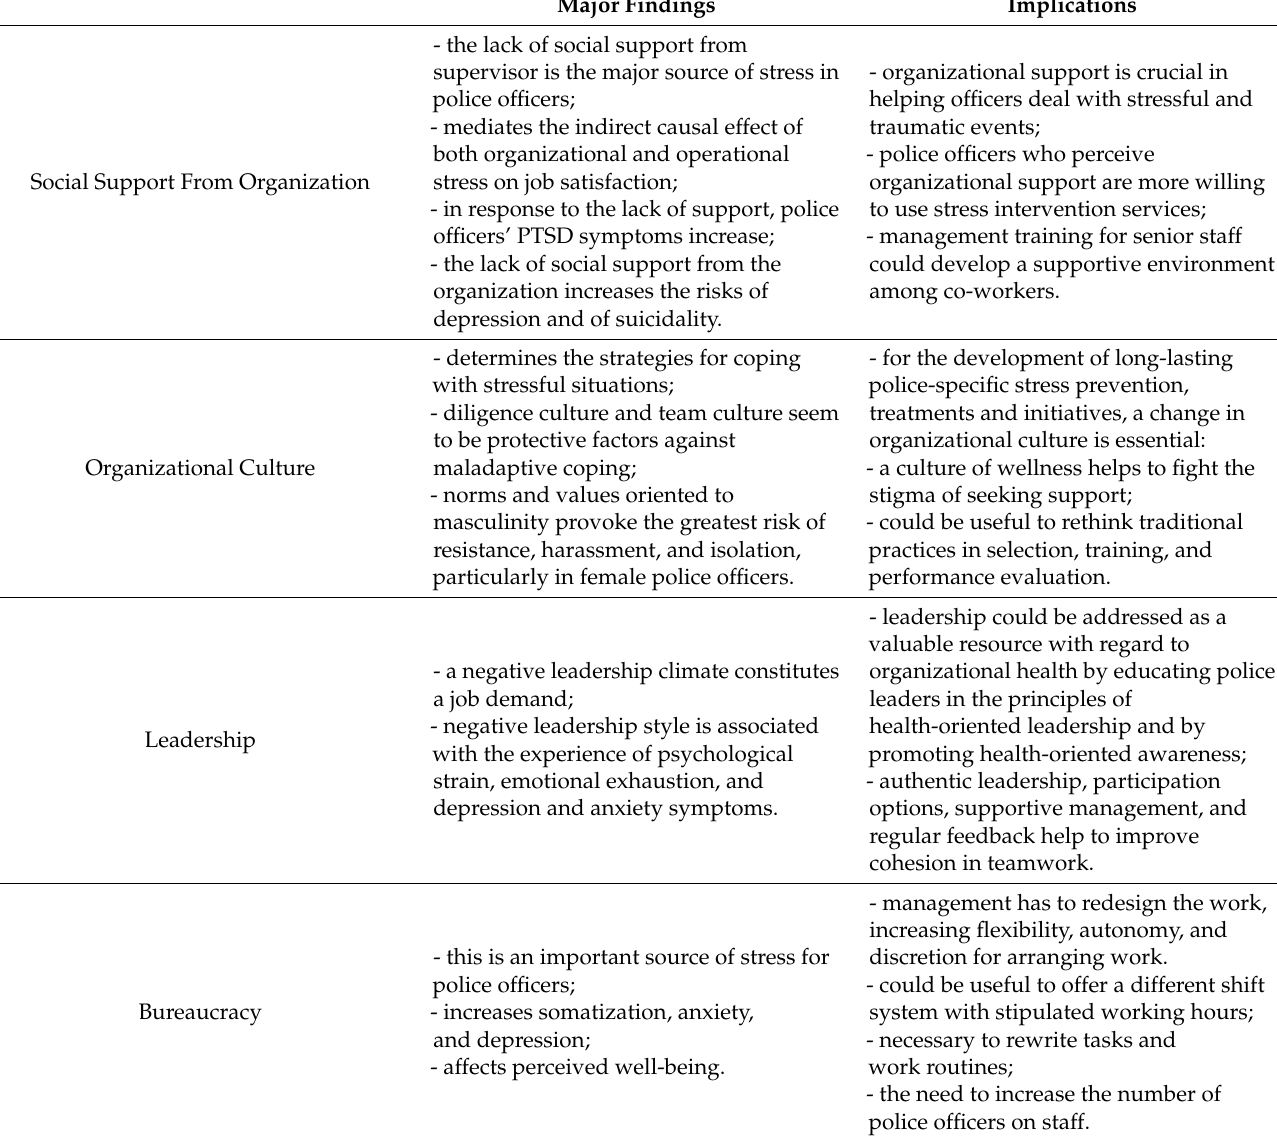
Table 1. Summary of main findings and